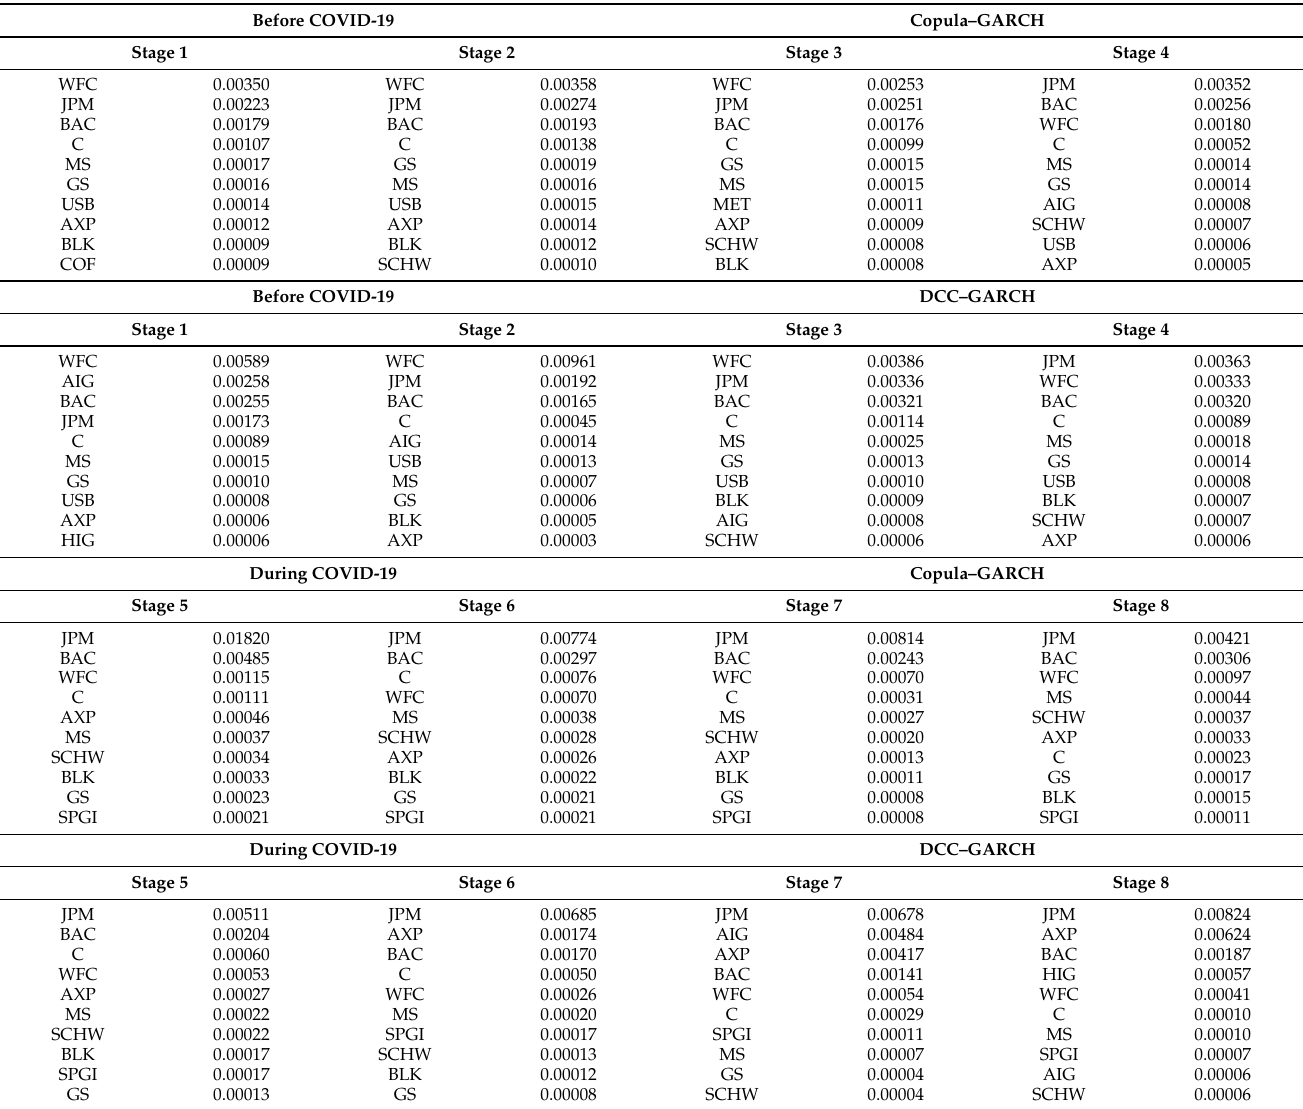
Table 5. Top 10 US financial firms ranks by CES before and during